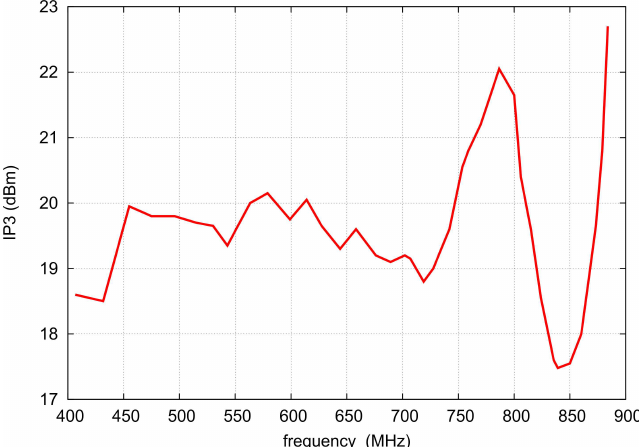
Figure 18. Exemplary current distribution in the stopband (1000 MHz) of the filter.